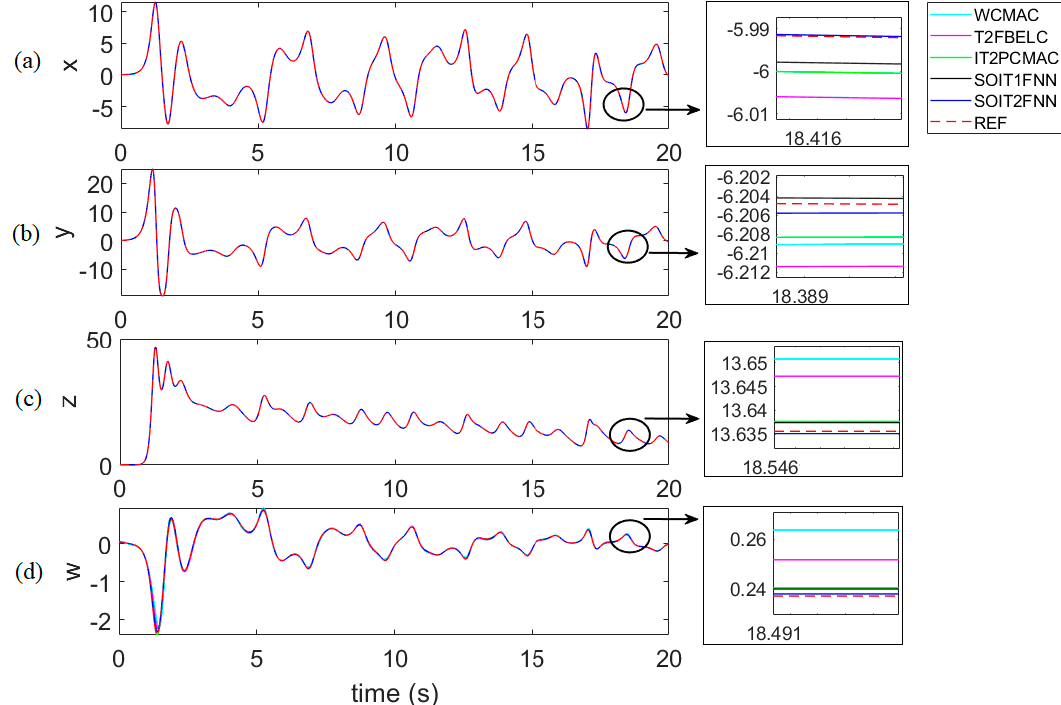
Figure 23. System outputs between the proposed SRIT2PC and other synchronization methods for Case 4: ( a ) x 1 , x 2 , ( b ) y 1 , y 2 , ( c ) z 1 , z 2 , and ( d ) w 1 , w 2 .